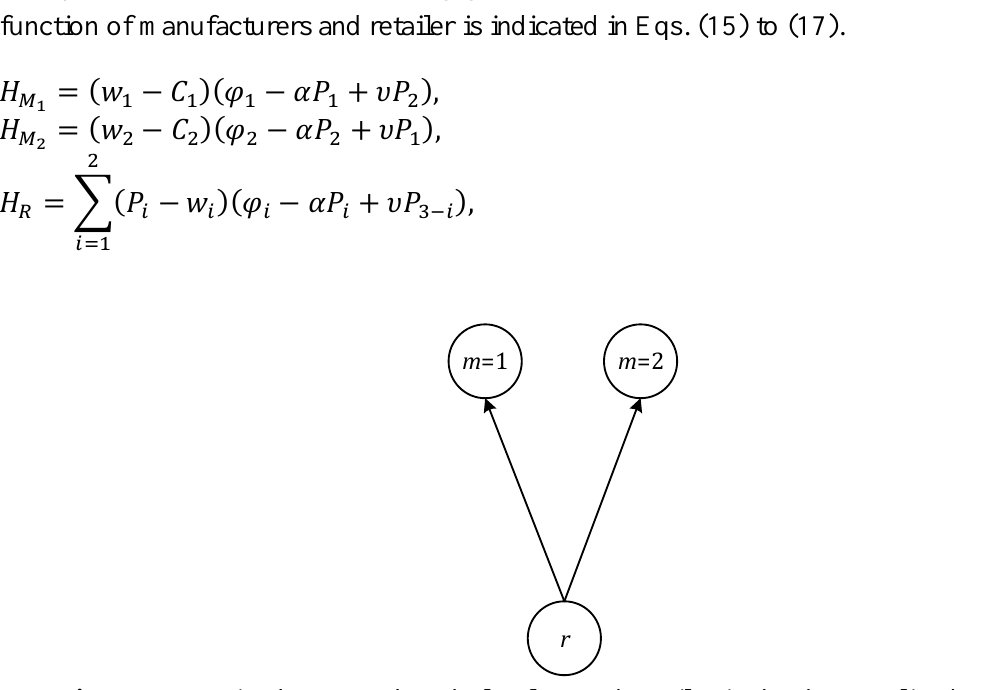
Fig. 3. Interaction between the wholesalers and retailer in the decentralized